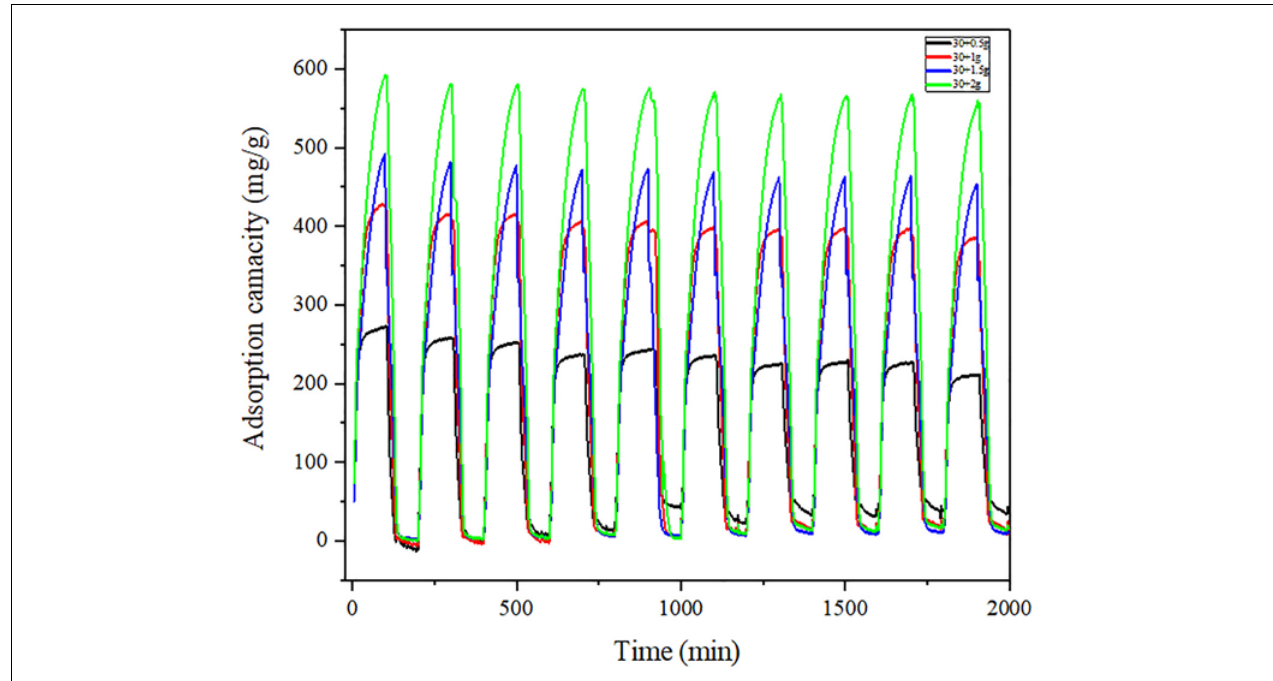
FIGURE 11 | Adsorption desorption cycle curve under actual working conditions (100 min for each process).